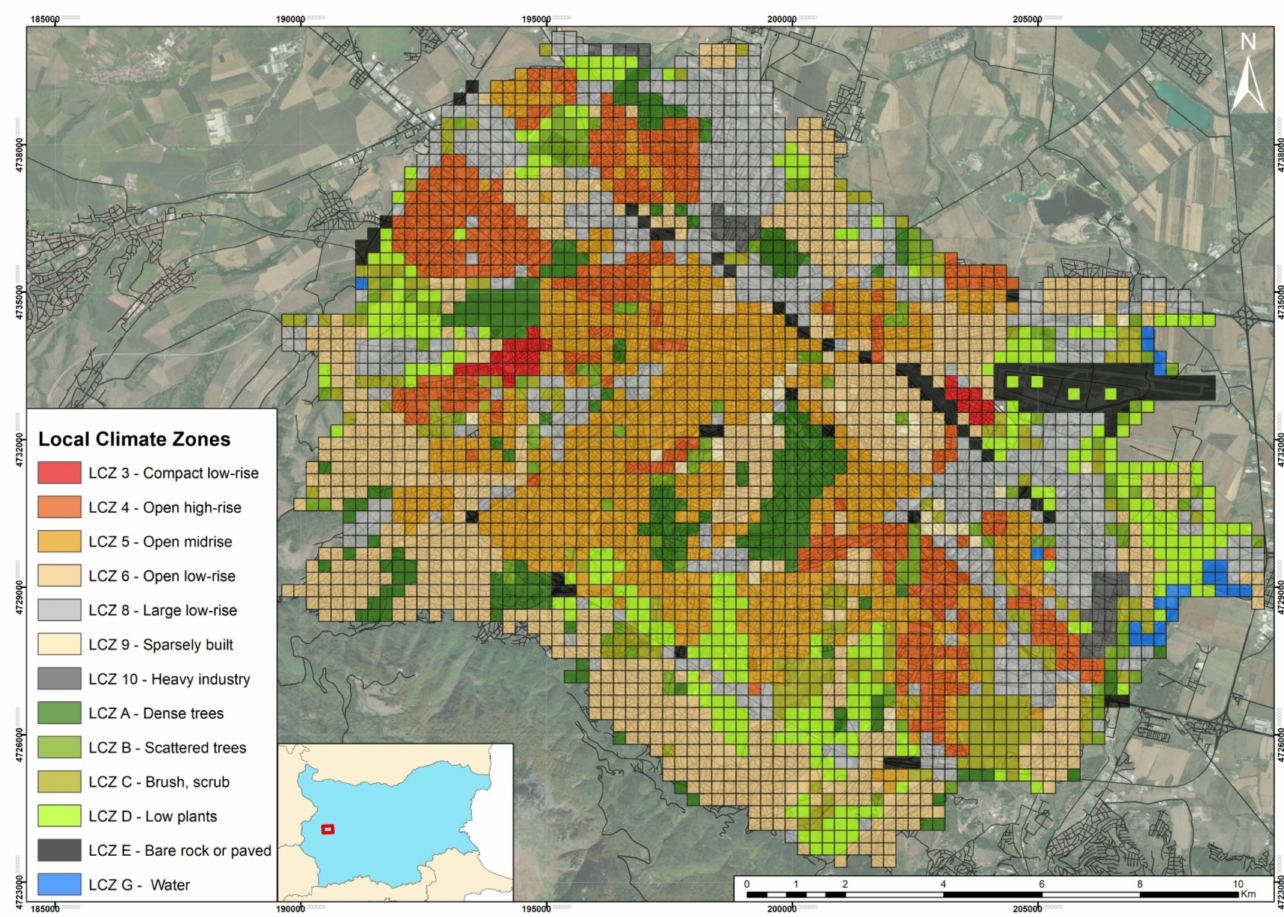
Figure 1. LCZs in Sofia as a grid of size 250 × 250